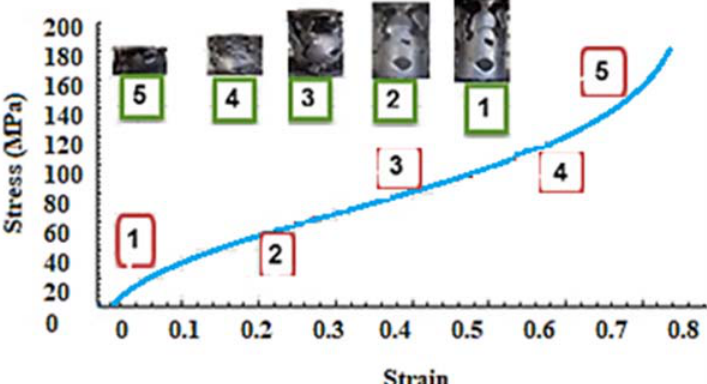
Figure 11: Stress-strain for an aluminum foam specimen.